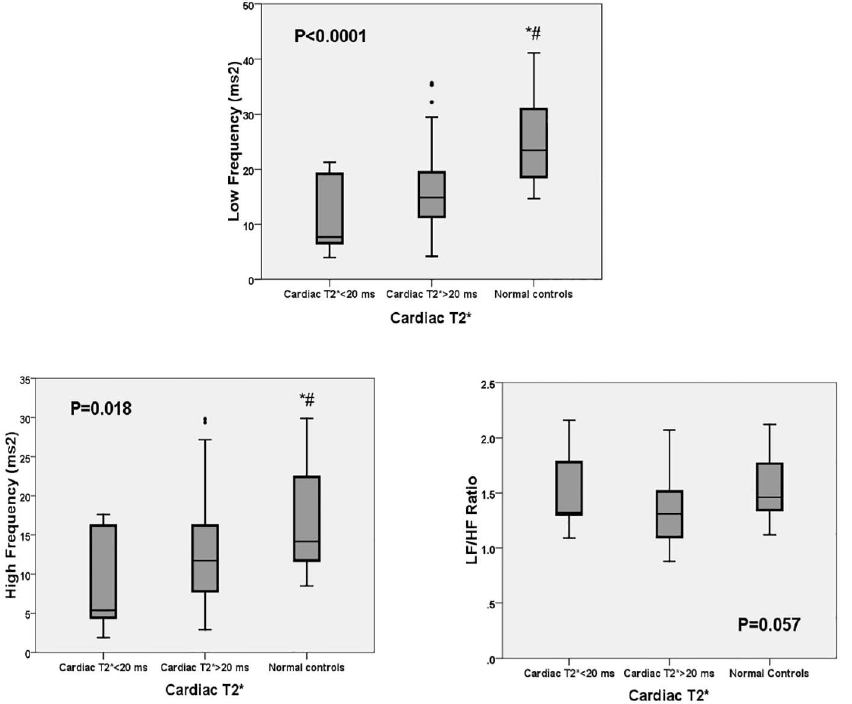
Fig 3. Graphing display comparing the frequency domains of HRV (LF, HF and LF/HF ratio) according to cardiac T2 * . LF, low frequency power; HF, high frequency power. * —p < 0.05 vs. cardiac T2 * < 20 ms; #—p < 0.05 for cardiac T2 * > 20 ms vs. normal